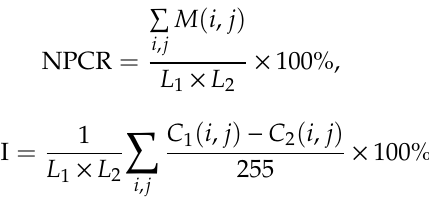
Table 1. NPCR and UACI.